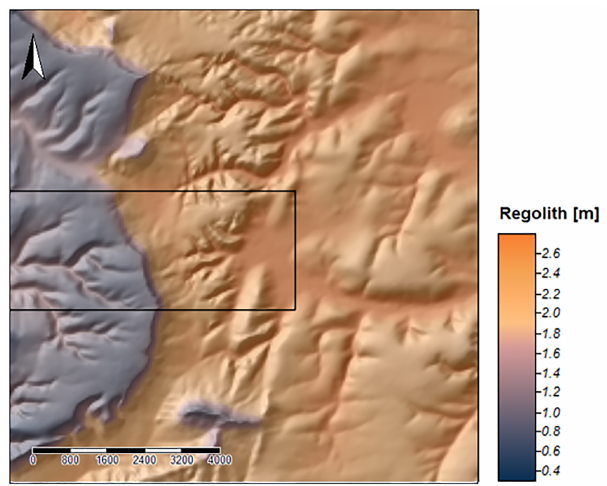
Figure 7. First results of the SaLEM simulation in Ebergötzen showing distributed regolith thicknesses resulting from 50ka mod- eling. The rectangle indicates the area where a first validation of the results was conducted.